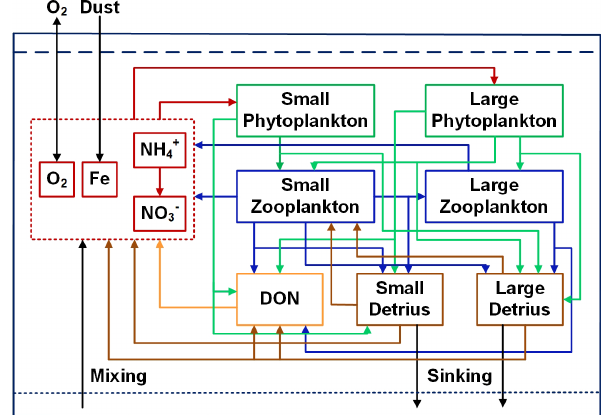
Figure 1. Flow diagram of the ecosystem model. Red, green, blue, yellow, and brown lines and arrows denote fluxes originating from inorganic forms, phytoplankton, zooplankton, DON, and detritus,